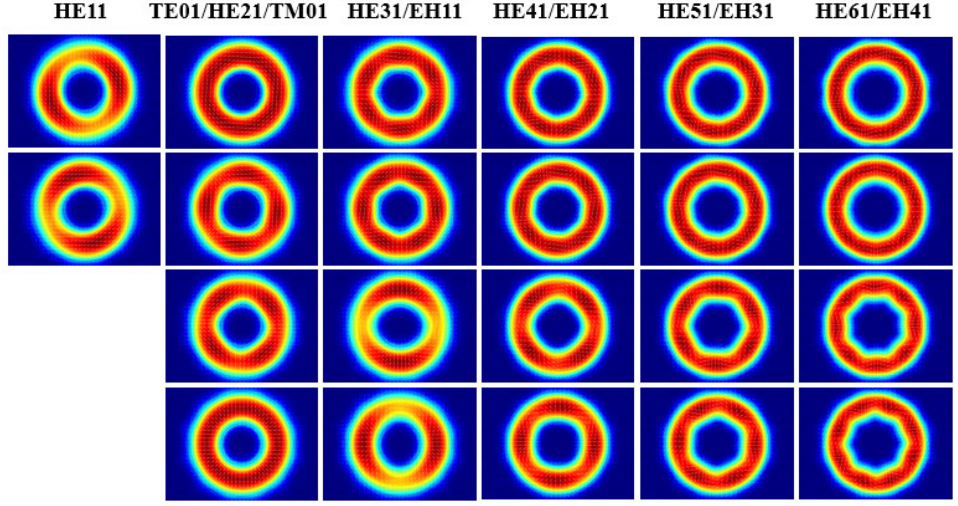
Figure 4. The intensity distribution of the electric field for the vector mode in the terahertz OAM PCF.